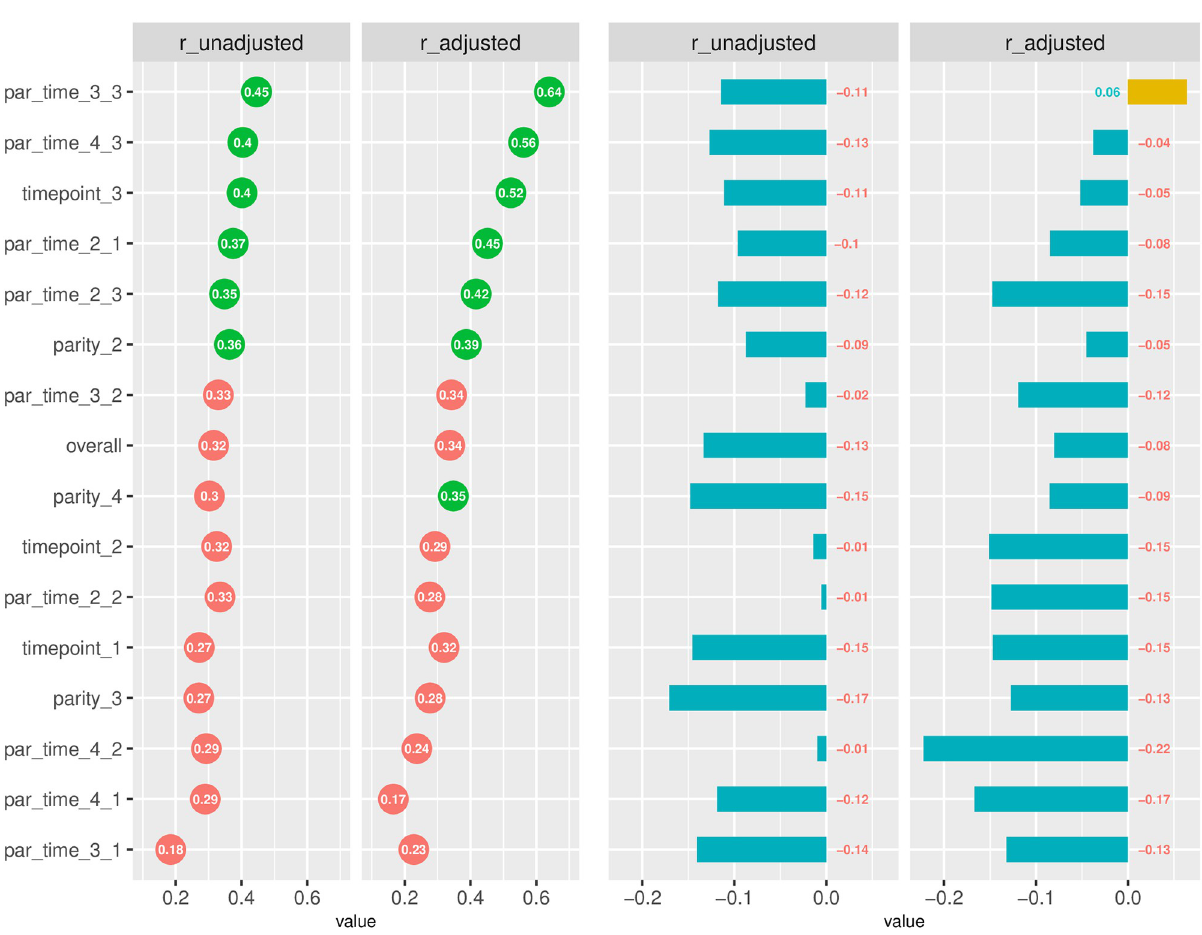
Fig 4. SCC vs DSCC for IMI detection. Pearson correlations between DSCC and log (SCC) when applying the editing criteria for SCC recommended in Damm et al, 2017 (SCC in [50k, 1.5M]. On the left, unadjusted and adjusted (model-based, equations (1,2,3)) correlations: green/red circles represent correlation coefficients above/below the average. On the right, differences with correlations estimated from the editing criteria applied in this study (SCC in [1k,10M]): negative/positive values represent smaller/larger values compared to the results from the present study. The comparison has been normalised by size (same data size in both sets of